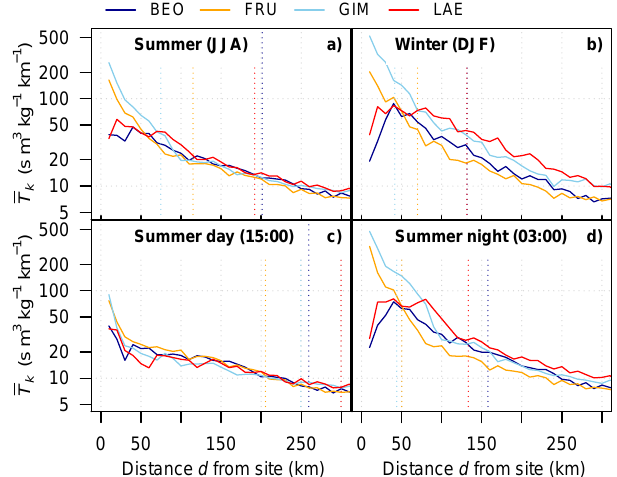
Figure 11. Surface sensitivities as a function of distance from the measurement site position T k (Eq. 3). Lines are color coded ac- cording to measurement site (Beromünster: dark blue, Früebüel: orange, Gimmiz: light blue, Lägern-Hochwacht: red). The vertical dotted line is the radius at which the cumulative surface sensitiv- ity starting from the measurement site’s position reaches 50% of the simulation domain total, τ s50 . (a) Summer (June–August 2013), (b) winter (December 2013–February 2014), and (c) and (d) sum- mer afternoon (15:00UTC) and at nighttime (03:00UTC), respec- tively. Please note the logarithmic y axis and that, during winter, for Beromünster and Lägern-Hochwacht the 50% vertical dotted lines overlap. The site-specific particle release heights are listed in Table 2. Local time is central European time (CET or UTC +